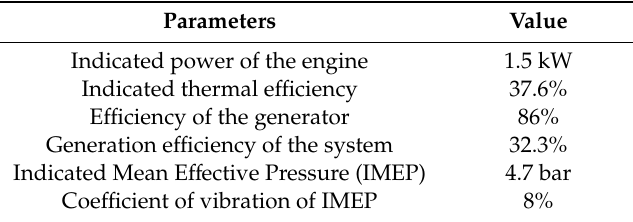
Table 4. The tested performance of the prototype